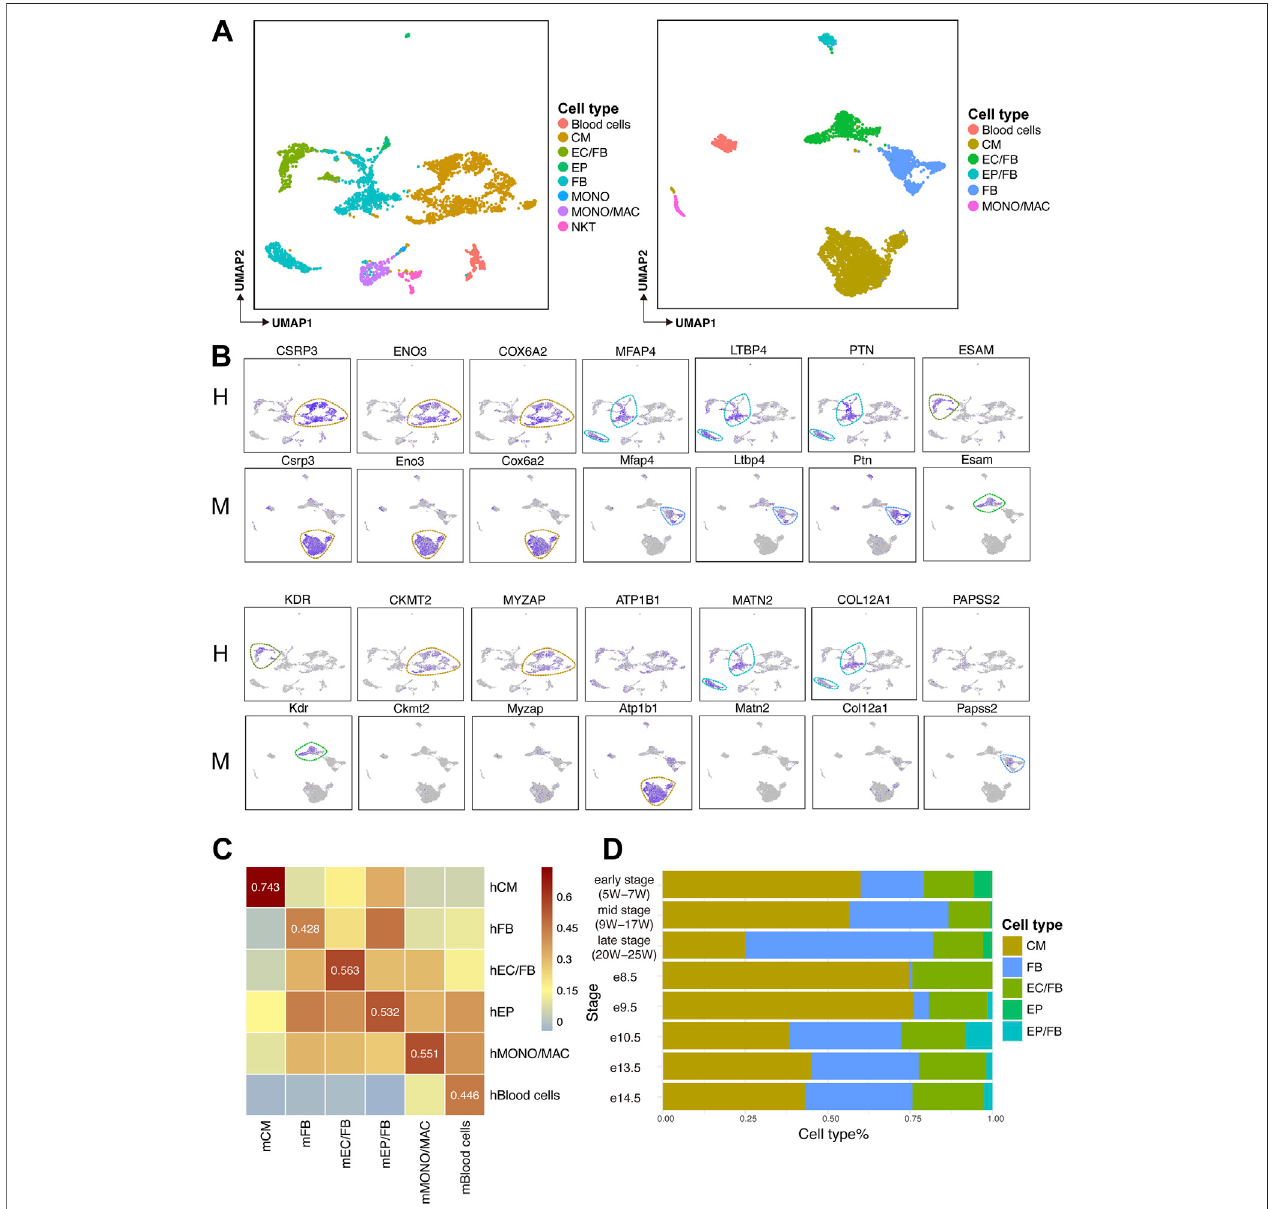
FIGURE 2 | Expression levels of marker genes in human and mouse heart and comparison of cell type correlation and cell type composition ratio across species. (A) UMAP plots showing the cell types of human (H, left) and mouse (M, right) fetal heart development. (B) UMAP plots showing the expression levels of each marker gene in human (H) and mouse (M). (C) Heatmaps showing the Pearson correlations of major cell types between human (H) and mouse (M) fetal heart. (D) Bar plot showing the cell composition at each stage of human and mouse heart